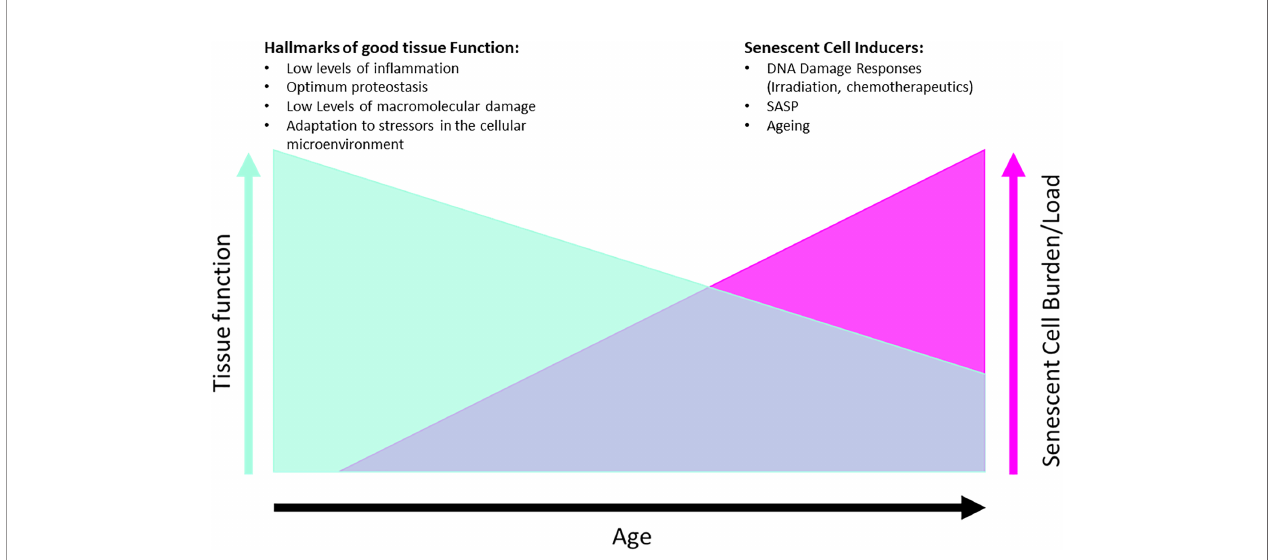
FIGURE 3 | Hypothesis of effects of senescent cell removal therapies on tissue function, with examples of each of different hallmarks and drivers listed for both conditions. Graphs are not directly proportional as mitigating factors can alter the tissue functionality such as diet, exercise,